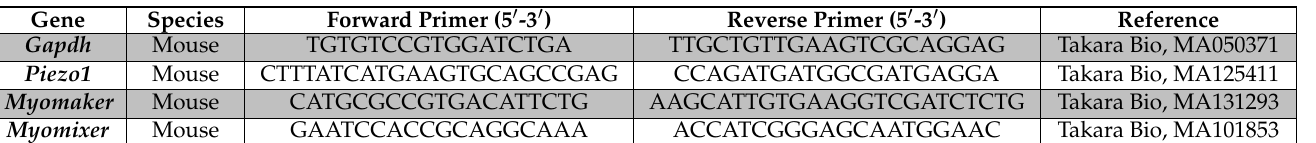
Table 2. RT-qPCR